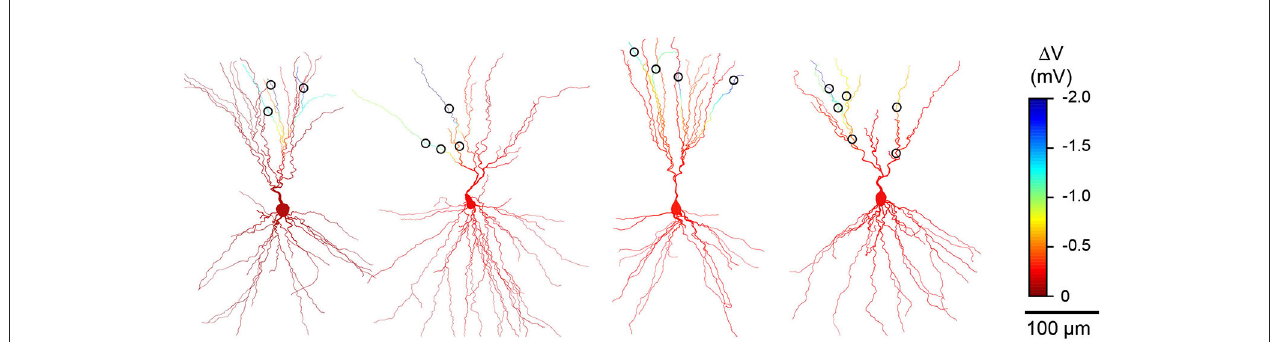
L3 PCs and L1 interneuron synaptic contacts (circles). Color scale indicates simulated change in membrane potential during co-activation of all inhibitory synaptic contacts.